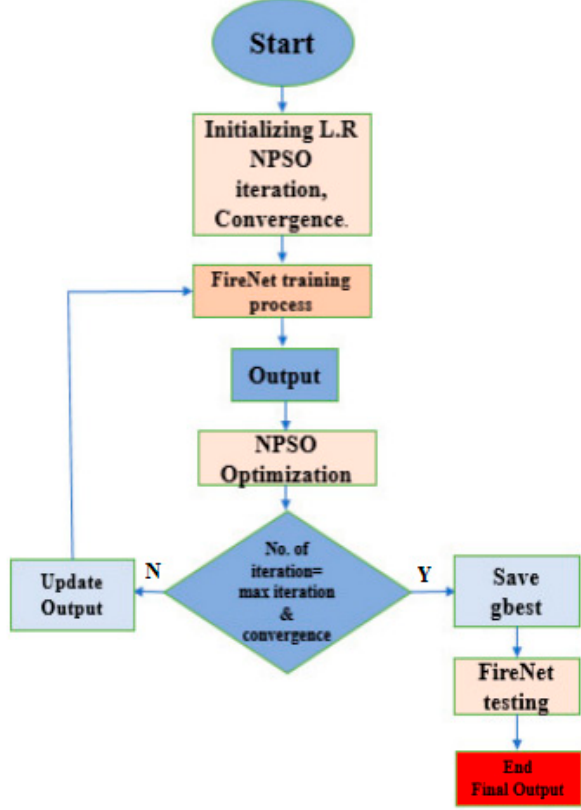
Figure 4. Flowchart of the proposed NPSO